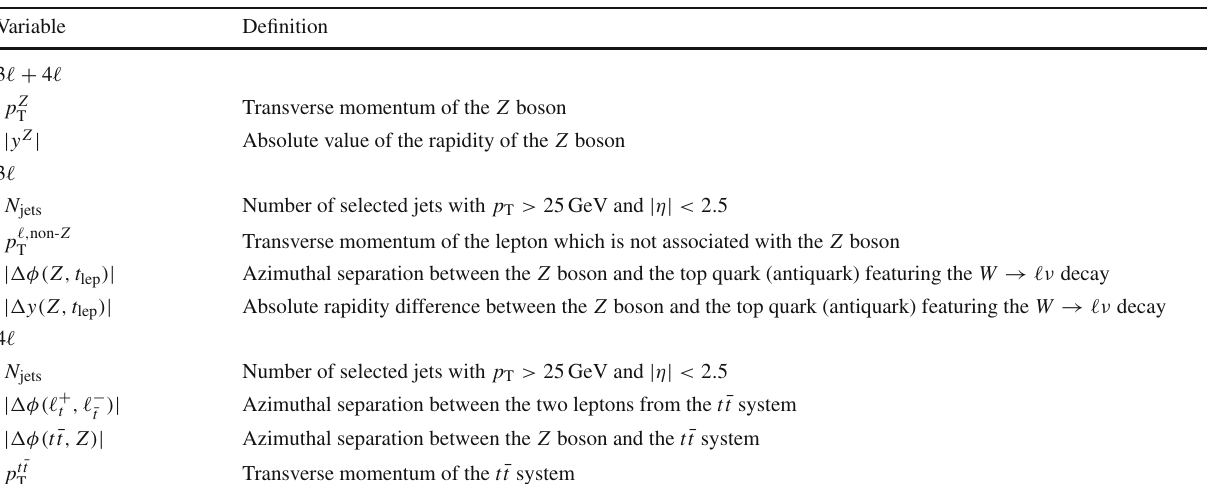
the two topologies separately, whereas for the variables related only to the kinematics of the Z boson ( p Z and | y Z | ), the trilepton and tetralep- T ton regions are